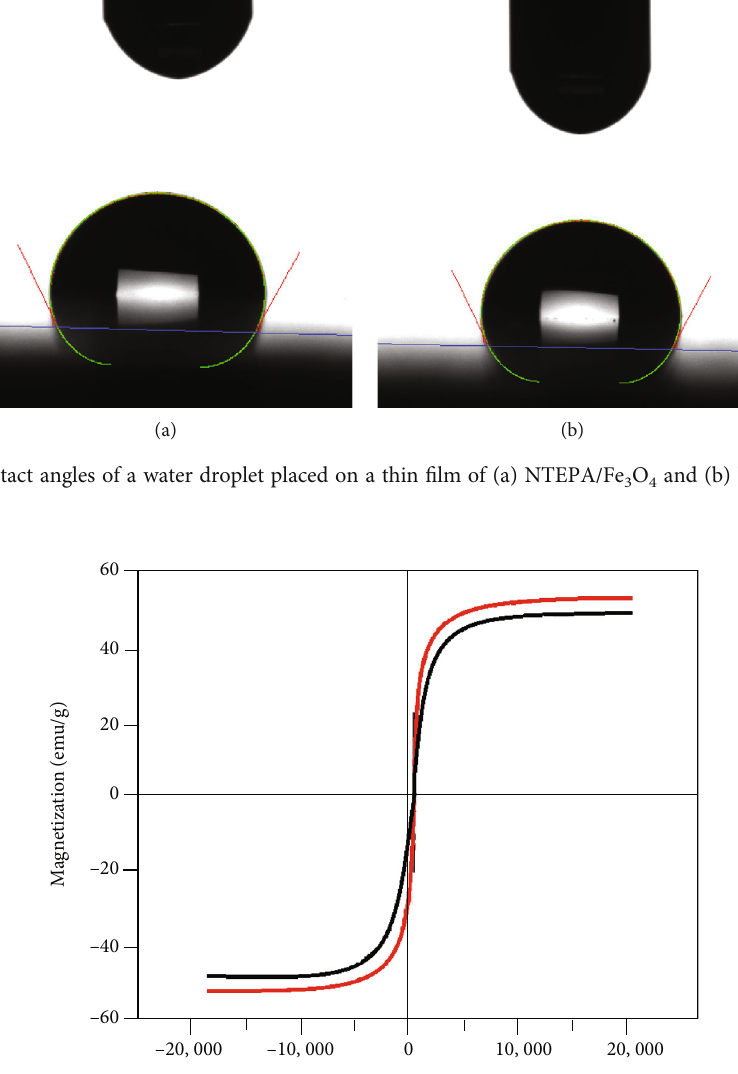
O and NDETA/Fe 3 4